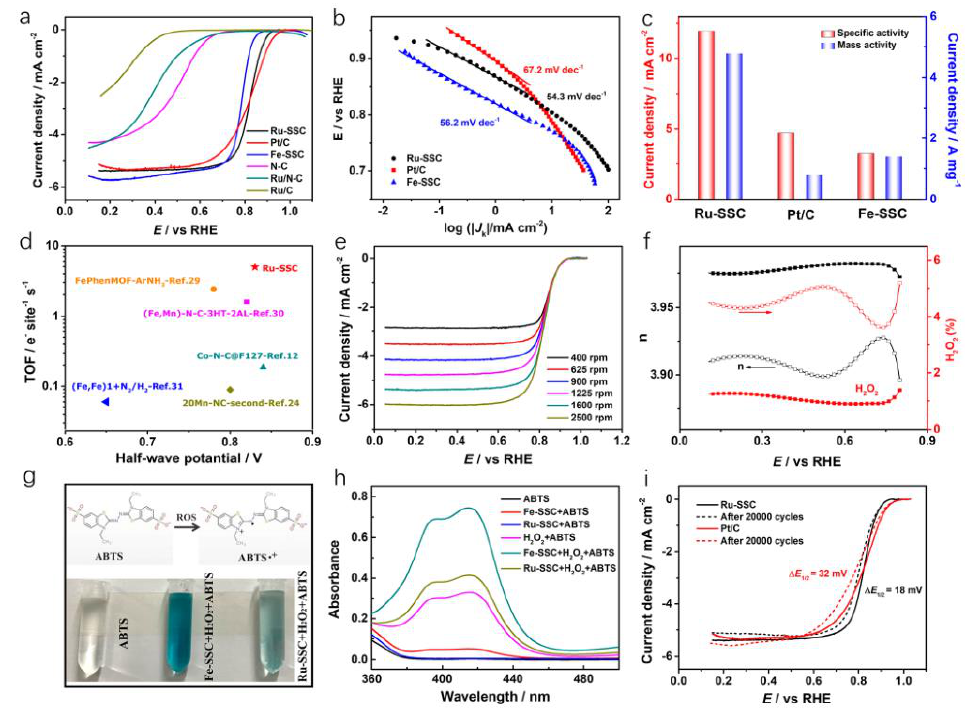
Figure 12. ( a ) ORR polarization curves of the synthesized catalysts at a scanning speed of 5 mV s − 1 at 1600 rpm; ( b ) Tafel slopes of Ru-SSC, Pt/C, and Fe-SSC; ( c ) comparison of specific and mass activities of Ru-SSC, Pt/C, and Fe-SSC; ( d ) TOF (at 0. 8V vs RHE) as well as Ru-E1/2 values for SSC and other recently reported SSCs; ( e ) LSV curves for Ru-SAC with different rotation rates; ( f ) H 2 O 2 production and the calculated electronic transfer numbers of Ru-SSC (solid squares) and Fe-SSC (hollow squares); ( g ) reactions of ROS and ABTS (top) and a photograph showing the color change of the solution after the Fenton reaction (bottom); ( h ) UV − Vis absorbance spectra of 0.1 M HClO 4 solution including only the following: abts; Ru-SSC and abts; H 2 O 2 and abts; Fe-SSC and abts; Ru-SSC, H 2 O 2 and abts; Fe-SSC, H 2 O 2 , and abts after 7 min of reaction. ( i ) Potential cycling stability test before and after ORR the polarization diagram. (Reprinted with permission from [146]. Copyright 2019, American Chemical